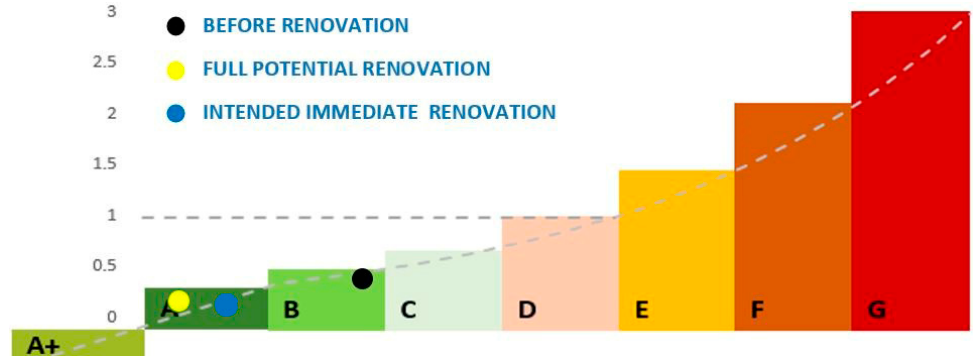
Figure 6. Energy rating results before and after the renovation on Building 8, Politecnico di Milano—Lecco Campus.